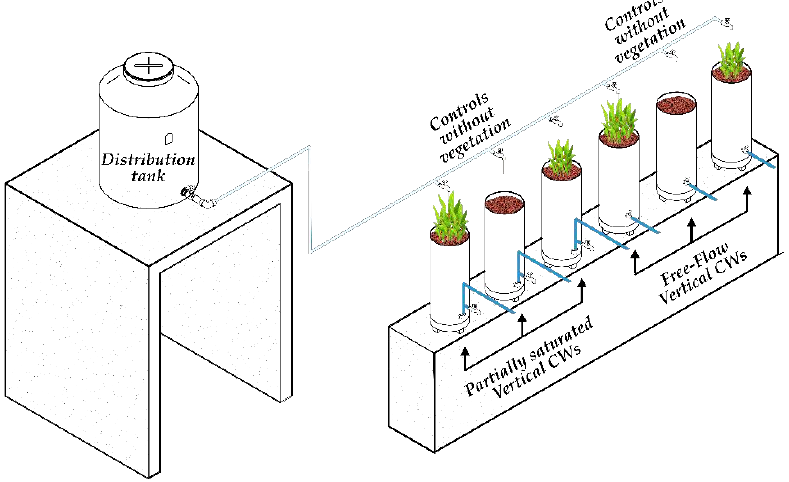
Figure 1. Pilot-scale constructed wetlands for the treatment of municipal/swine wastewater. Three vertical CW operated in free-flow conditions (FFV-CW) and the other three with partially saturated flow (PSV-CW); in these, the residual water level was maintained at 0.5 m from the bottom, favoring anaerobic conditions, and the remaining 0.5 m of height was free drainage (Figure 2).